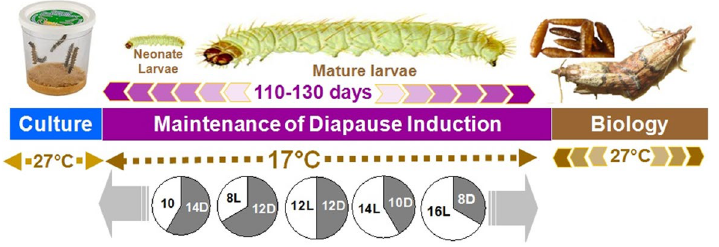
Figure 9. Schematic diagram for photoperiodic diapause induction in P. interpunctella